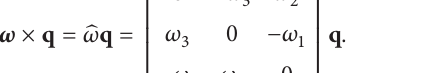
Figure 3: The mechanism of grasping rock passively (reference con- figuration).